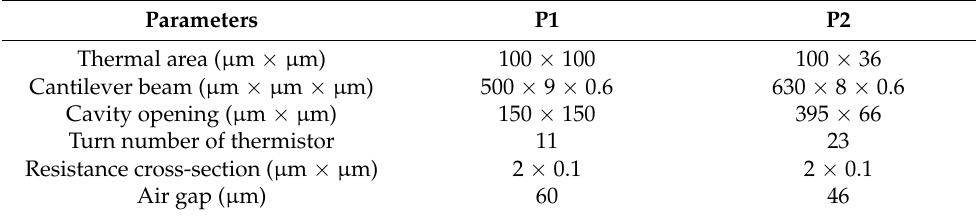
Table 3. Design parameters.